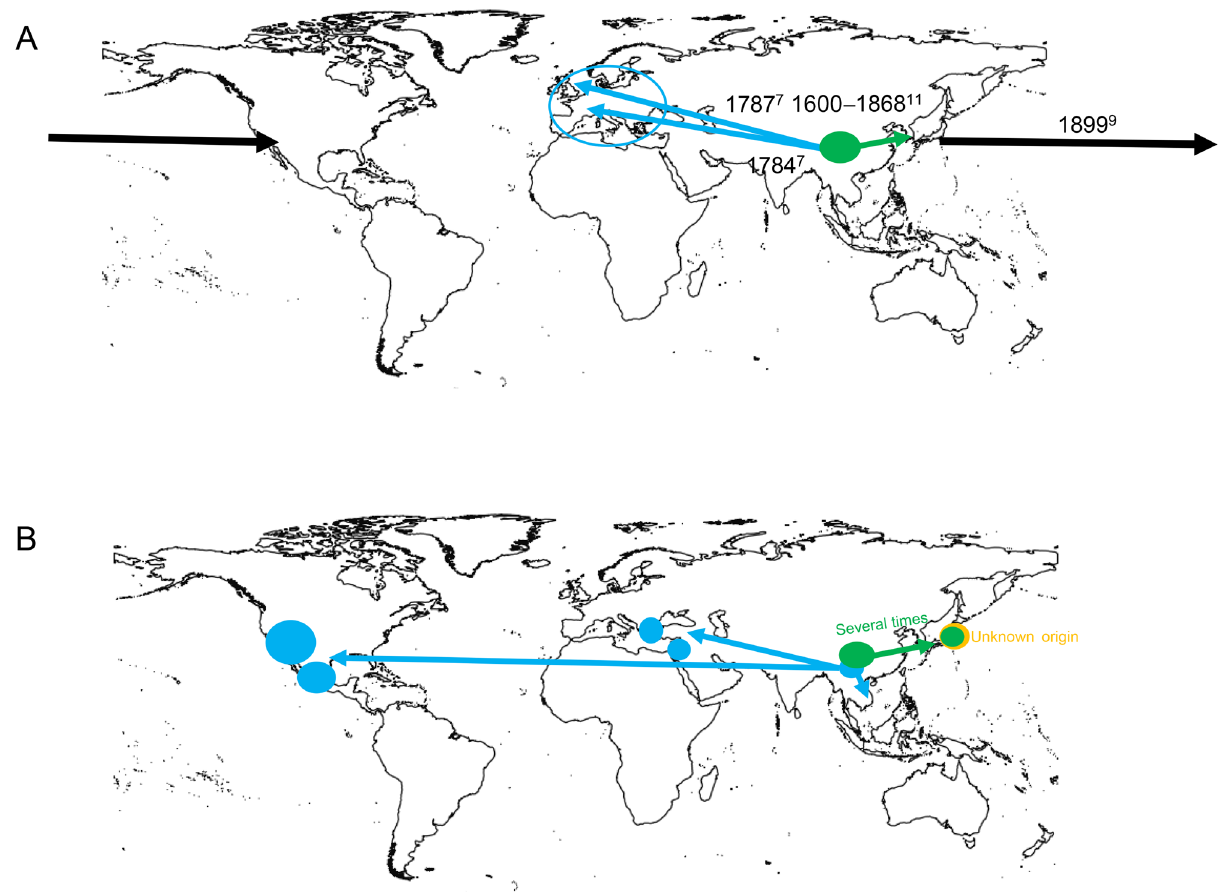
Figure 1. The spread of loquat from its origins in China to other parts of the world ( A : Propagation by citation) ( B : Propagation proposed by this study). The base map was produced using SimpleMappr (https:// www. simpl emappr. net/). Dark green circles indicate Group 1, dark blue circles indicate Group 2, and orange circles indicate Group